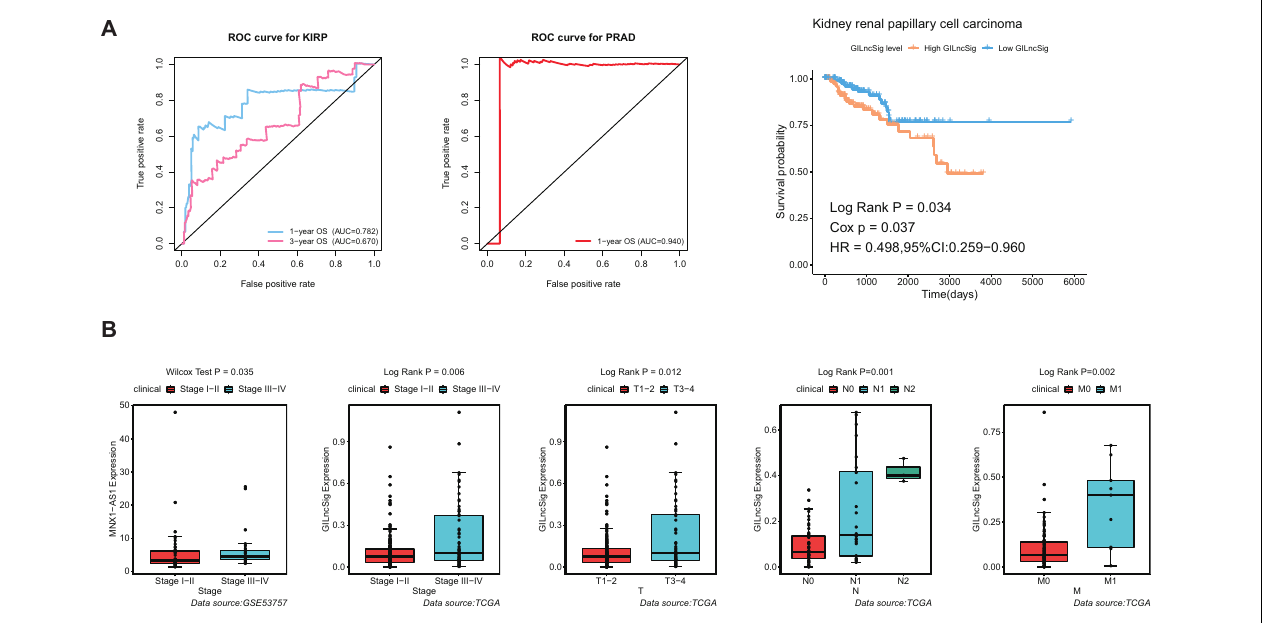
FIGURE 9 | Identification of the practicability of the GILncSig in other urinary tumors. (A) Time-dependent ROC curve analysis of the GILncSig in KIRP at 1 and 3 years, time-dependent ROC curve analysis of the GILncSig in PRAD at 1 year, and Kaplan–Meier curves of overall survival of GILncSig in KIRP. (B) Boxplot of MNX1-AS1 expression level between stage I–II and stage III–IV in GSE53757 dataset and boxplots of GILncSig levels in different clinical subgroups in TCGA KIRP dataset. The expression level of MNX1-AS1 was significantly associated with increasing level of stage and GILncSig was significantly associated with increasing level of clinical factors containing T, M, N, and